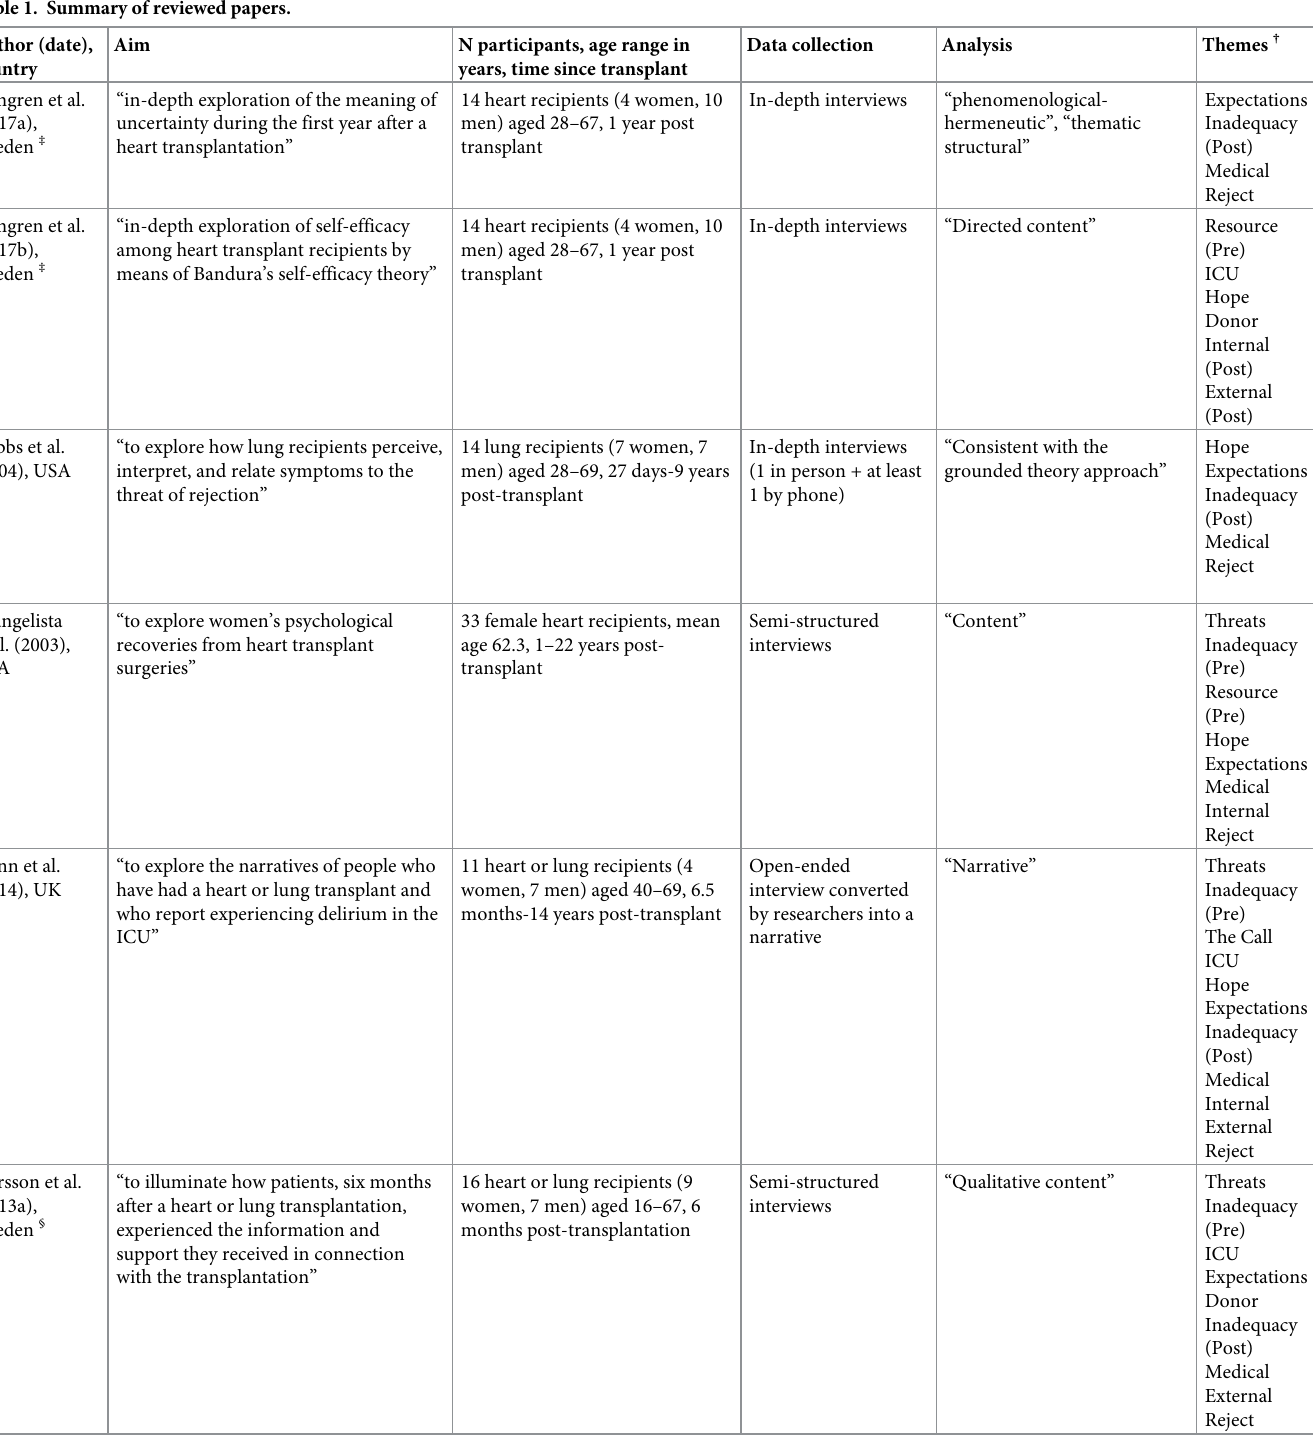
Table 1. Summary of reviewed